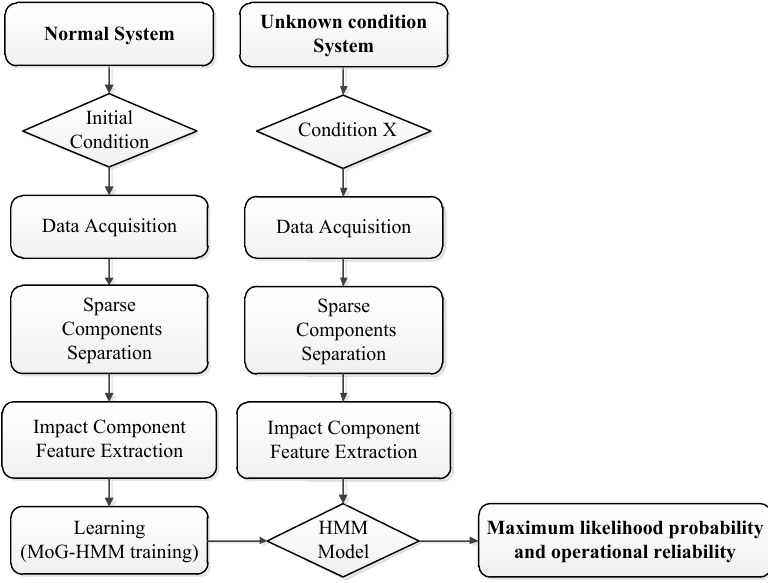
Figure 1. Flowchart of the few-shot reliability assessment approach.